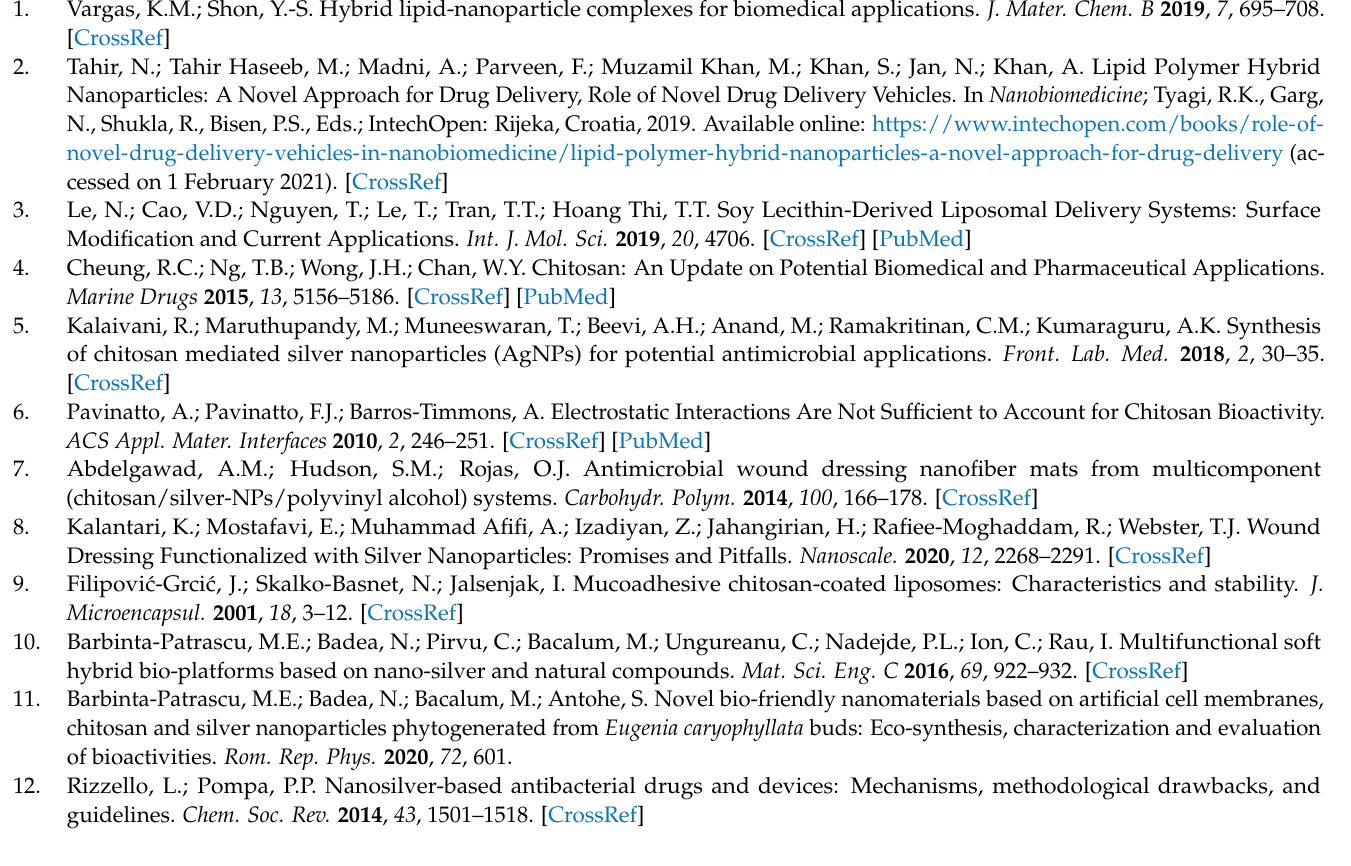
(Figure S4. Mean particle size (Zav, nm) and polydispersity index (PdI) of the samples, estimated